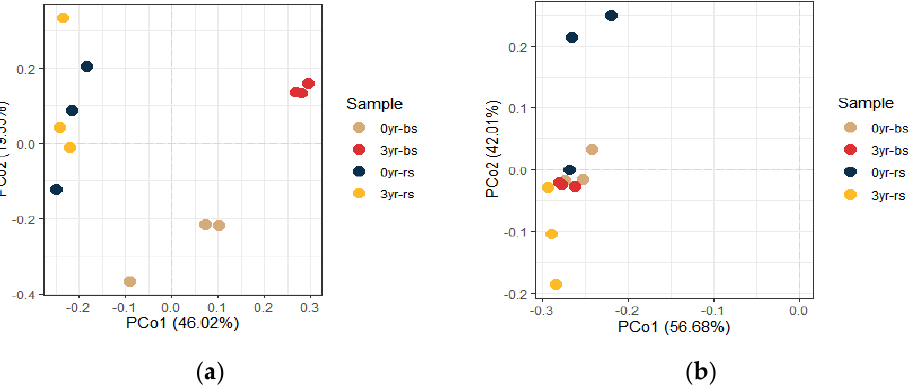
Figure 4. Principal component analysis of American ginseng rhizosphere when grown in soils with different monoculture history for fungi ( a ) and bacteria ( b ); 0 yr-bs: bulk soil with no American ginseng growing history; 3 yr-bs: bulk soil with 3-year monoculture; 0 yr-rs: rhizosphere in the soil with no American ginseng growing history; 3 yr-rs: rhizosphere in the soil with 3-year monoculture.